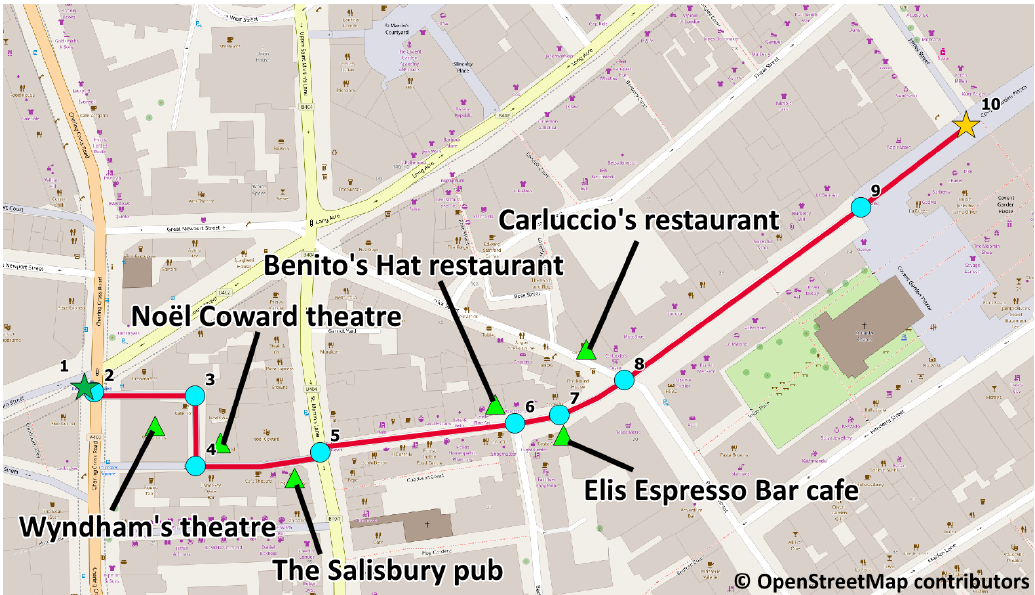
Figure 6. Route generated showing instruction points and landmarks used (base map © OpenStreetMap contributors).